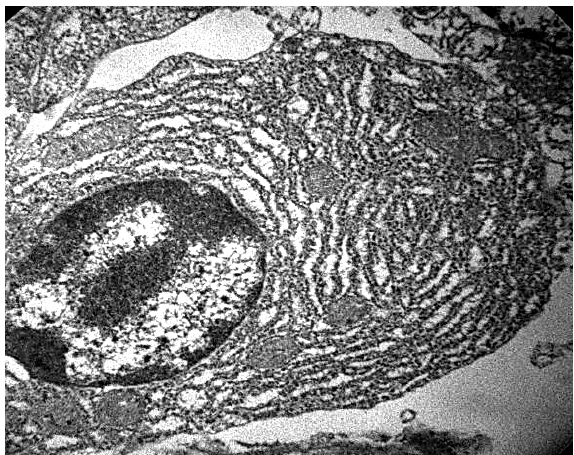
Fig. 9 . Electrogram of chicken’s plasmocytes, the 1 st group, Fig. 7. High RNA content in the chicken’s Bursa of the 30 th day of the test. The presence of ribosomes in the Fabricius plasmocytes cytoplasm, the 1 st group, the 30 th day of tubules of the granular endoplasmic reticulum. x 8000 the test. Brache. x 400